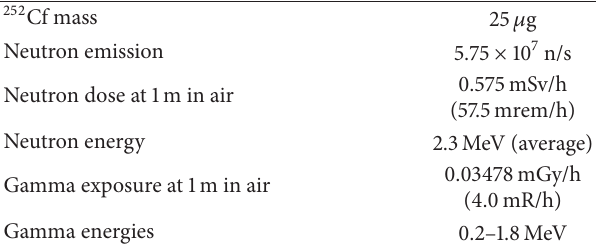
Table 3: 252 Cf source data without